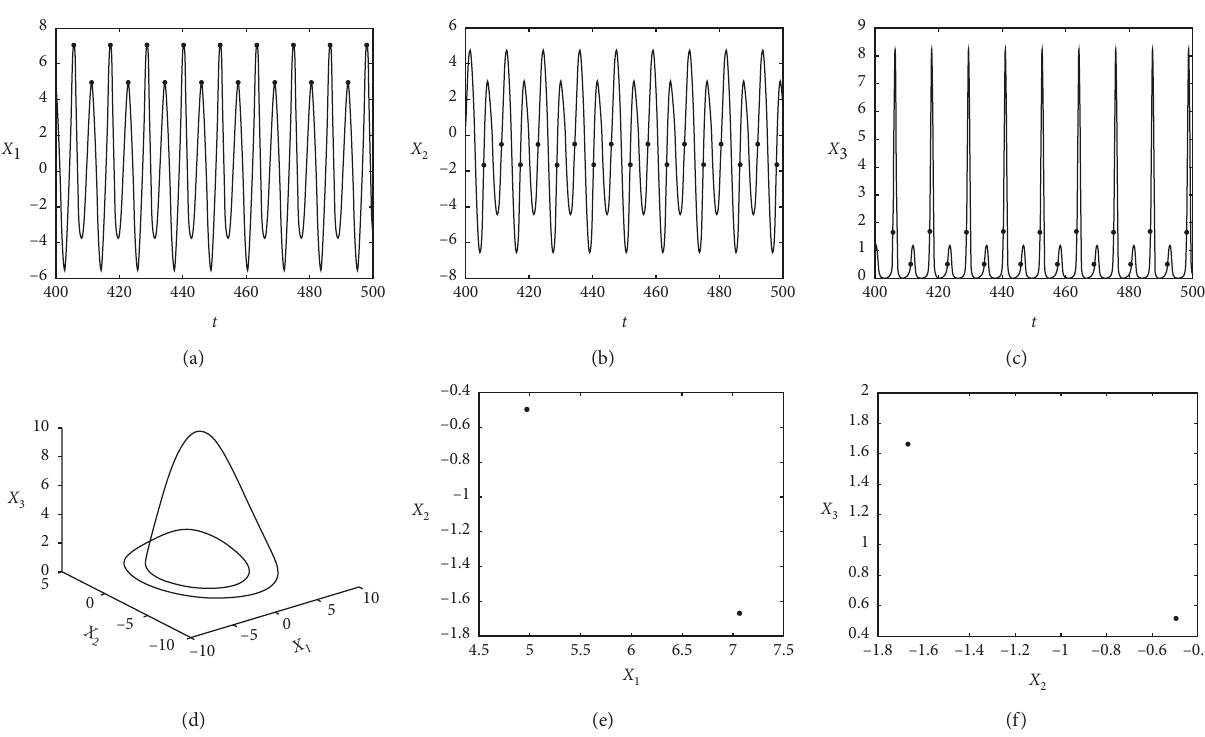
0.20, b 0.20, and c 3.50. (cid:31) (cid:31) (cid:31)